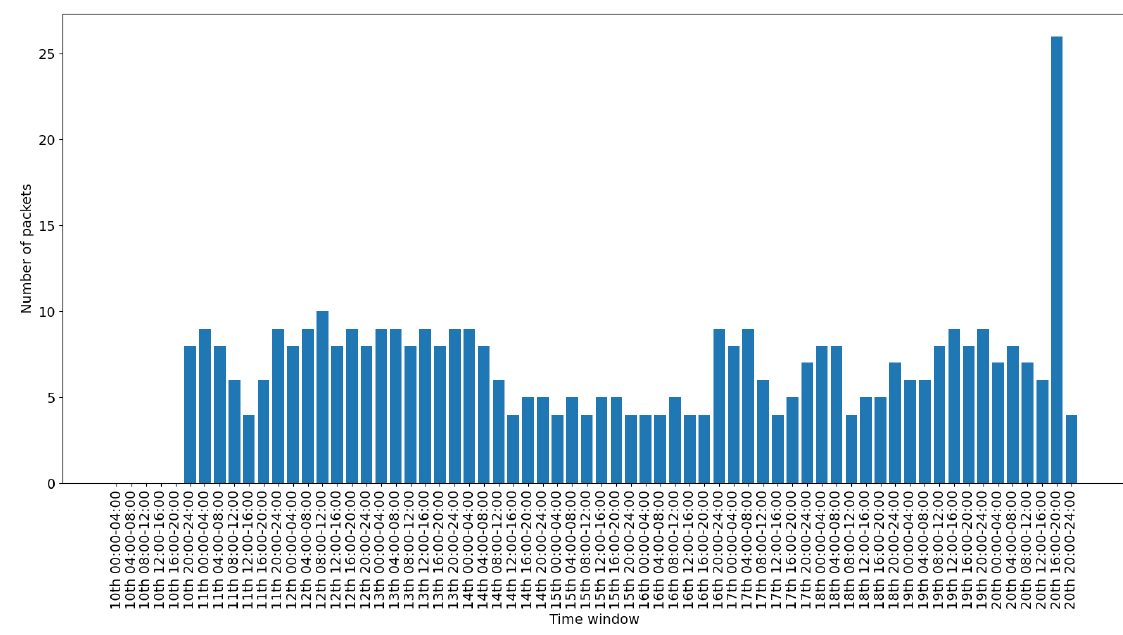
Figure 12. RF869 packets time distribution.